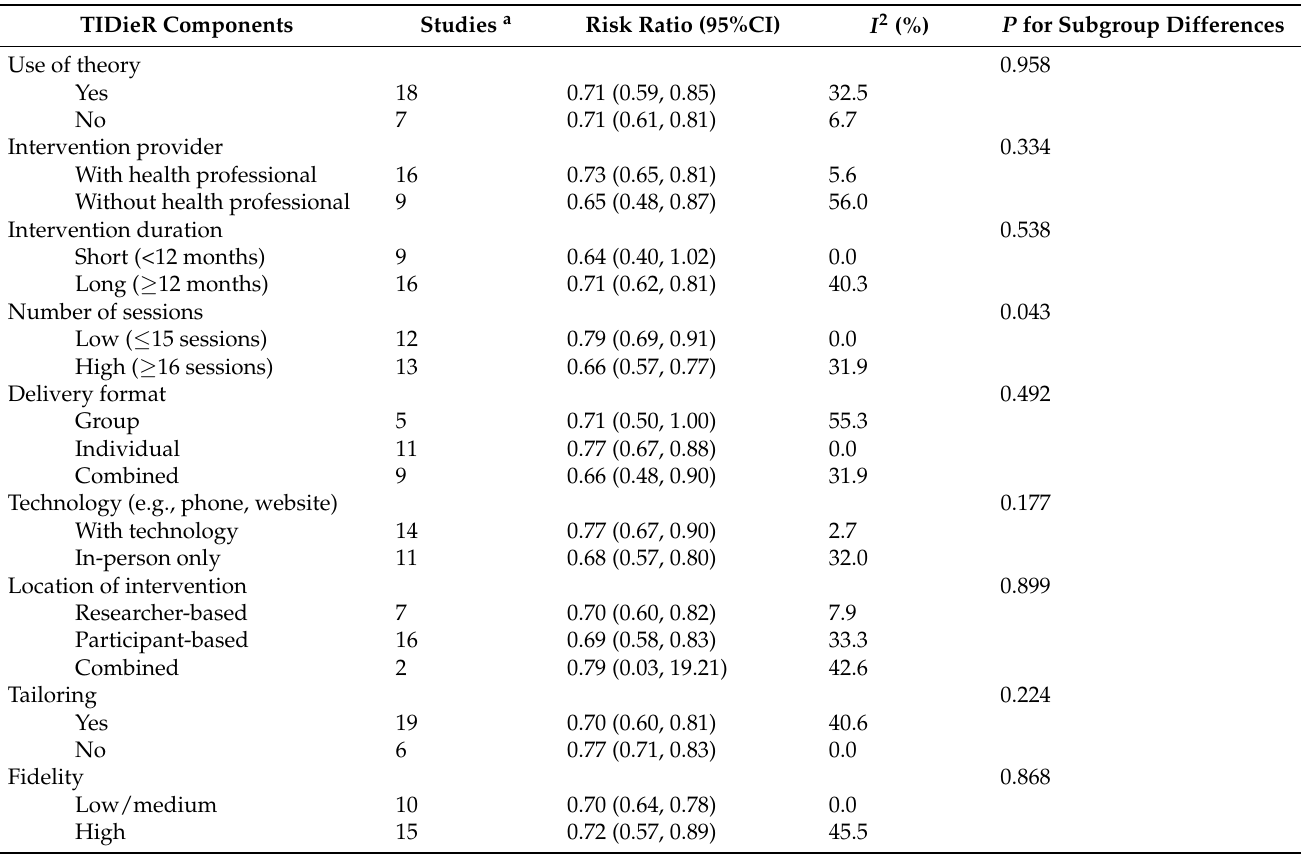
Table 1. Subgroup analyses of lifestyle intervention on diabetes incidence by TIDieR components.